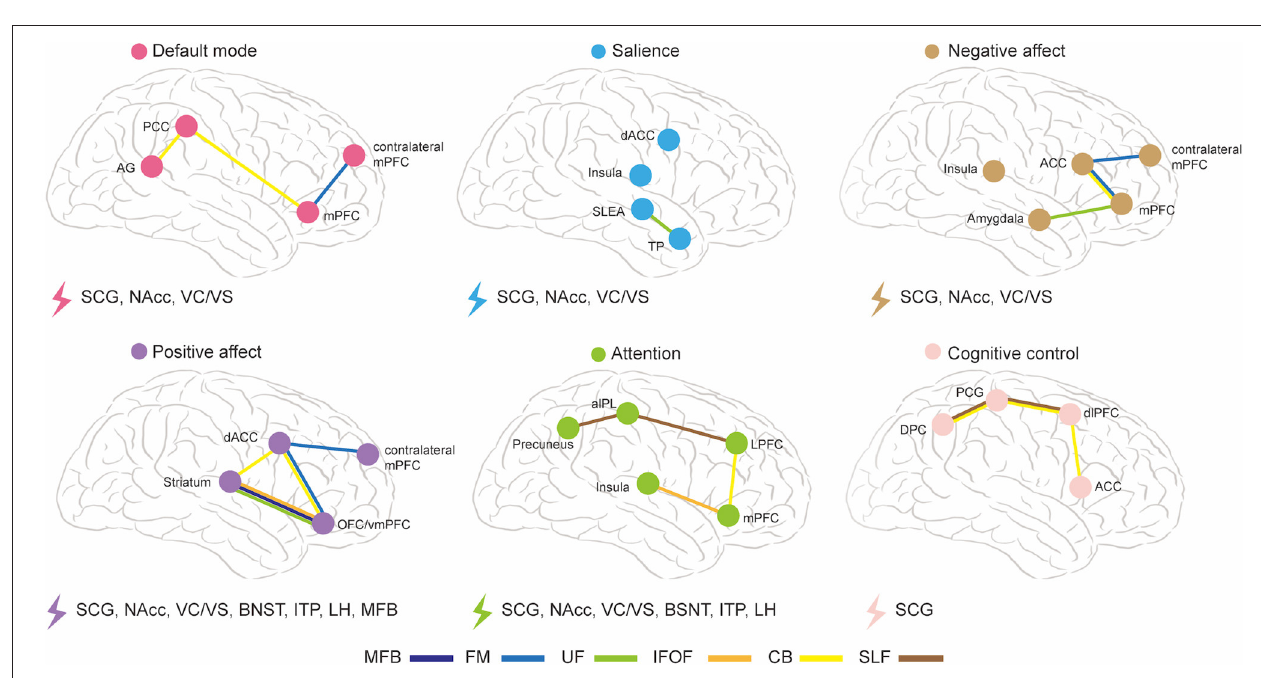
FIGURE 1 | The abnormal WMT and associated brain regions in MDD. The brain region node size represents the number of passing WMT. ACC, anterior cingulate cortex; ATL, anterior temporal lobe; ATR, anterior thalamic radiation; CB, cingulum bundle; CST, corticospinal tract; dlPFC, dorsal lateral prefrontal cortex; FM, forceps minor; IFOF, inferior fronto-occipital fasciculus; ILF, inferior longitudinal fasciculus; MFB, medial forebrain bundle; mPFC, medial prefrontal cortex; OL, occipital lobes; PL, parietal lobes; SLF, superior longitudinal fasciculus; UF, uncinate fasciculus.